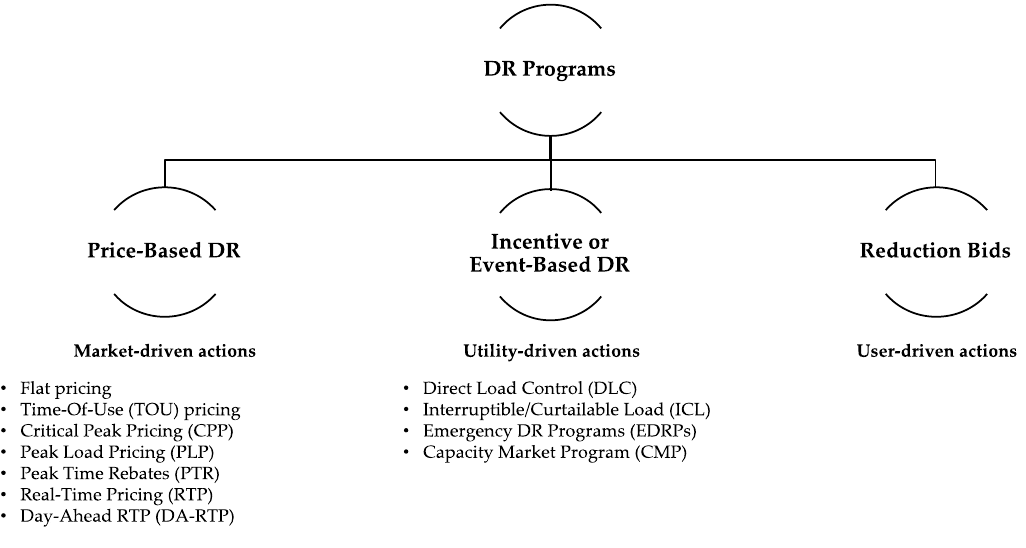
Figure 3. Classification of Demand Response (DR) programs in smart grids, according to the party that initiates the demand reduction action [44].